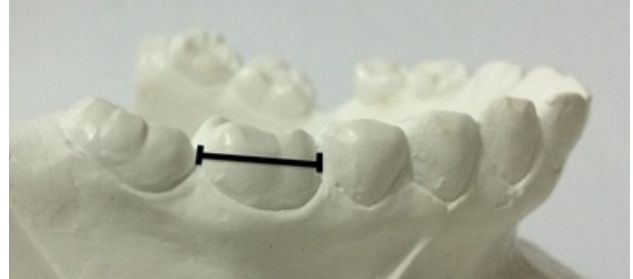
Fig.1. Mesiodistal distance. Source: current research.